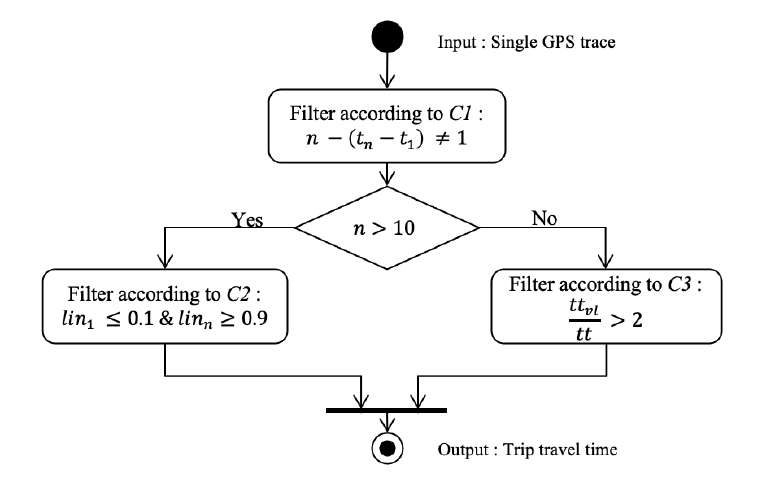
Figure 3. Trace travel time calculation